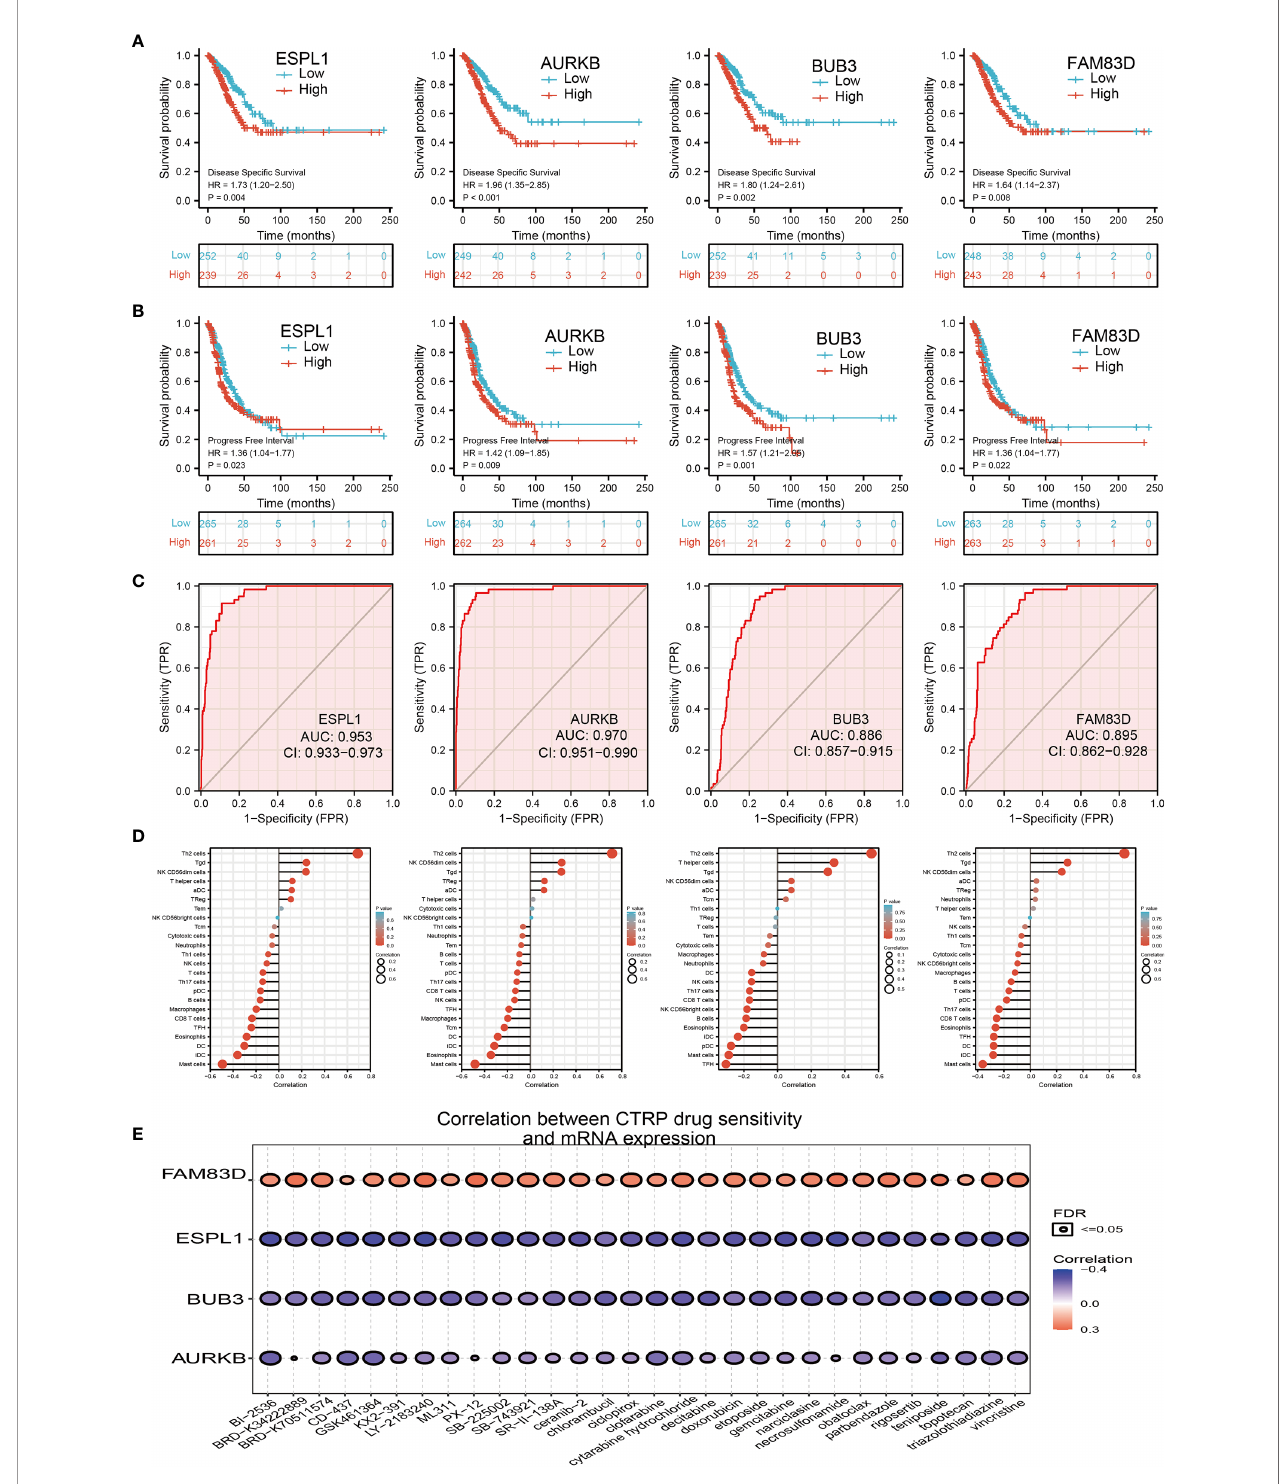
FIGURE 10 | Analysis of the GALNT3, CYCS, EIF5A, and ITGB4 expression and the immune level of correlation. (A, B) The DFS and PFS of ESPL1, AURKB, BUB3, and FAM83D in LUAD. (C) ROC curve of ESPL1, AURKB, BUB3, and FAM83D in LUAD. (D) The correlation between ESPL1, AURKB, BUB3, and FAM83D expression and the in fi ltration levels of 24 immune cells in LUAD. (E) The correlation between ESPL1, AURKB, BUB3, and FAM83D expression and the sensitivity of diverse drug determined by CTRP